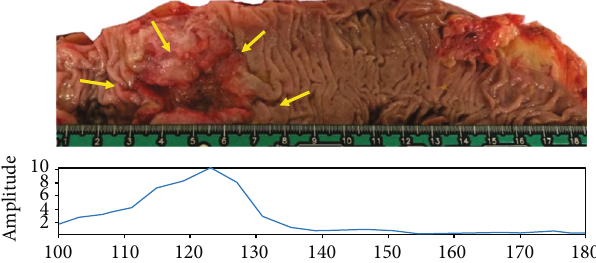
Figure 5: Correlation with the evolution of the maximum amplitude of each successive frame obtained with microwave- based colonoscopy (bottom) and the location of the lesion indicated by the arrows (top). Lower amplitudes around 0.2 are typical of healthy mucosa areas, while neoplastic lesions show high amplitudes close to